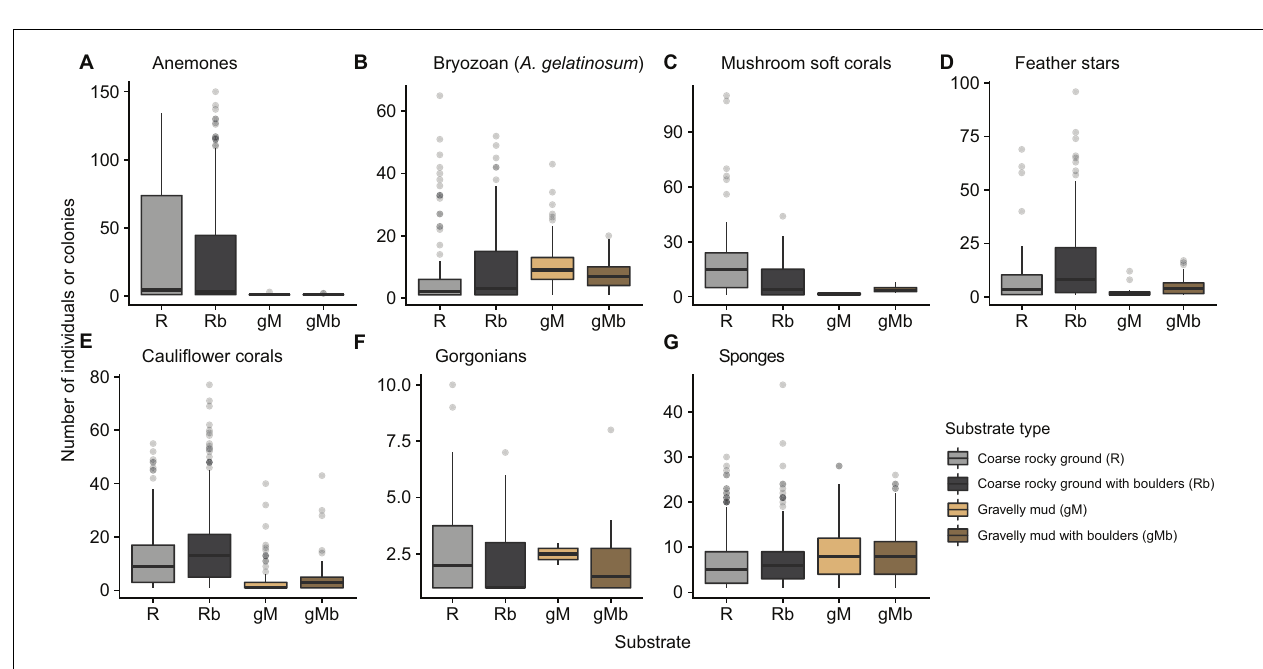
FIGURE 8 | Box-whisker plot showing the number of annotations of seven taxa (A–G) in images, which were annotated with one of four classes of substrate type. Substrate classes are based on the revised EUNIS Habitat Classification (Davies et al., 2004), as adapted by Gougeon et al. (2017) and further modified for the purposes of this